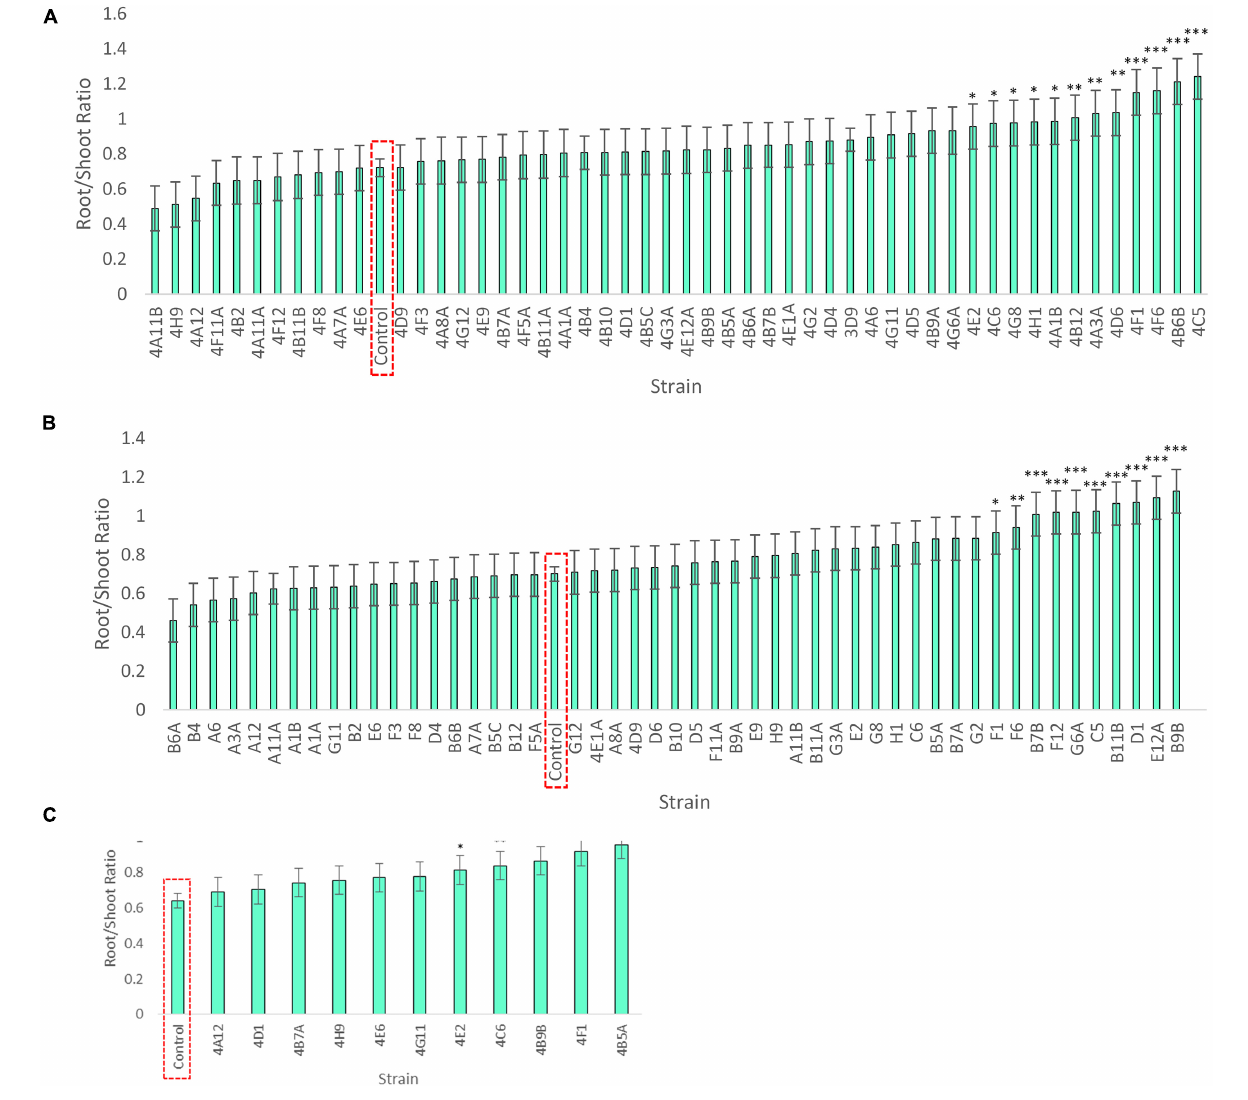
FIGURE 5 | Root/shoot biomass ratio of annual ryegrass following endophyte seed treatment. Shown is the data following 4 weeks of plant growth on N-free media for: (A) Trial 1, (B) Trial 2, and a subset in (C) Trial 3. The uninoculated control is outlined in red, and the data is ordered by increasing root/shoot ratio. Values significantly higher than the respective negative control are denoted by ∗ P < 0.1, ∗∗ P < 0.05, and ∗∗∗ P < 0.01 as determined by F -tests. Error bars represent the standard